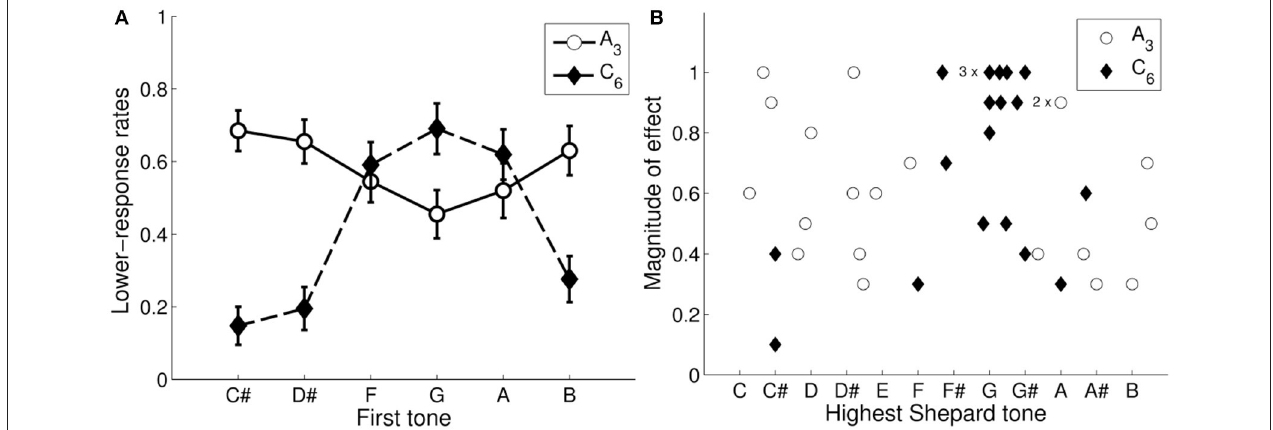
FIGURE 6 | Tritone paradox in the control condition. Averaged lower responses as function of the first Shepard tone generated under the A 3 - and the C 6 -envelope. The error bars represents the standard error of mean (A) . The distribution of the individual highest Shepard tones and magnitudes of effect under the envelope centered at A 3 and C 6 for each participant ( B , n = 20); the magnitude of effect was quantified as the difference of the minimum and the maximum of the individual response function. 2 participants for the A 3 -envelope and 3 participants for the C 6 -envelope had identical values for the highest Shepard tone and the magnitude of first-tone effect.